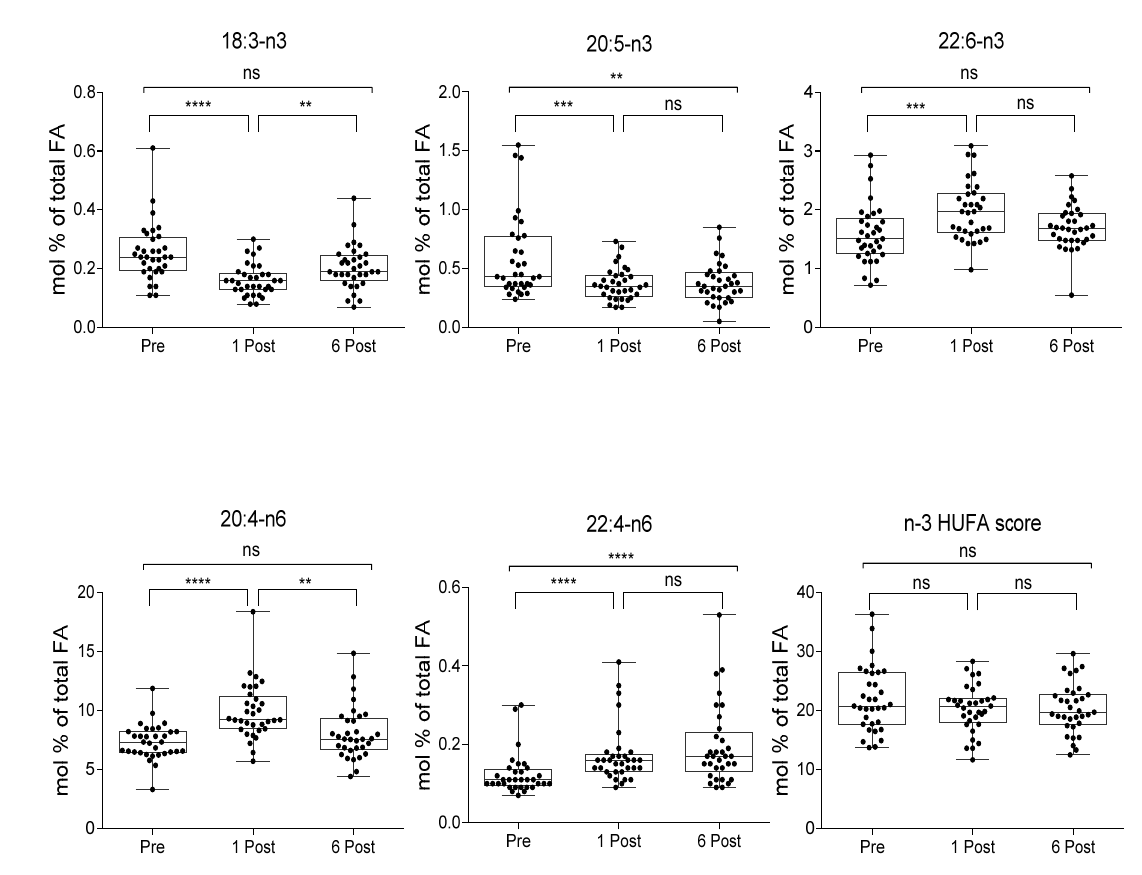
Figure 3. Plasma FA and *n3 HUFA scores in subjects at baseline (Pre), one month (1 Post) and six months (6 Post) after bariatric surgery. Values, expressed as mol % of total fatty acid (FA), are presented as boxes (mean value) and whiskers (higher and lower values) ( n = 33). ** p < 0.01; *** p < 0.001; **** p < 0.0001.